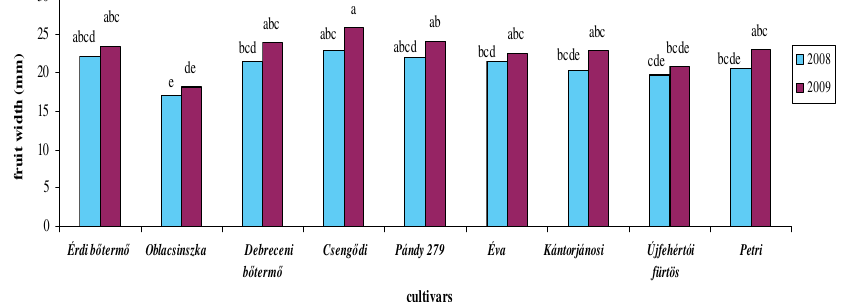
Figure 2. Fruit width of the studied sour cherry cultivars in tow years (2008 & 2009). Different letters indicate significant differences between treatments (P